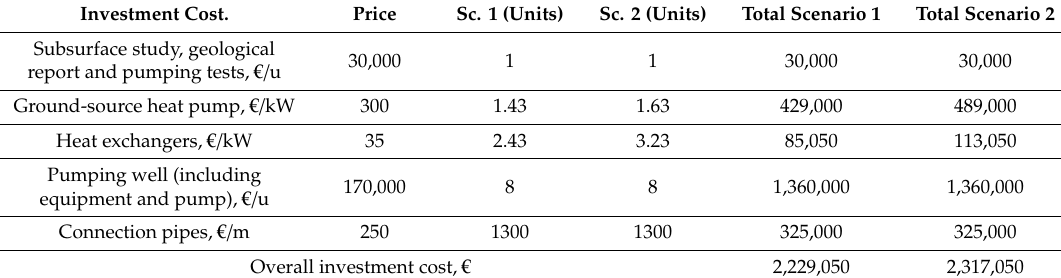
Table 5. Economic parameters of GSHP–ATES.